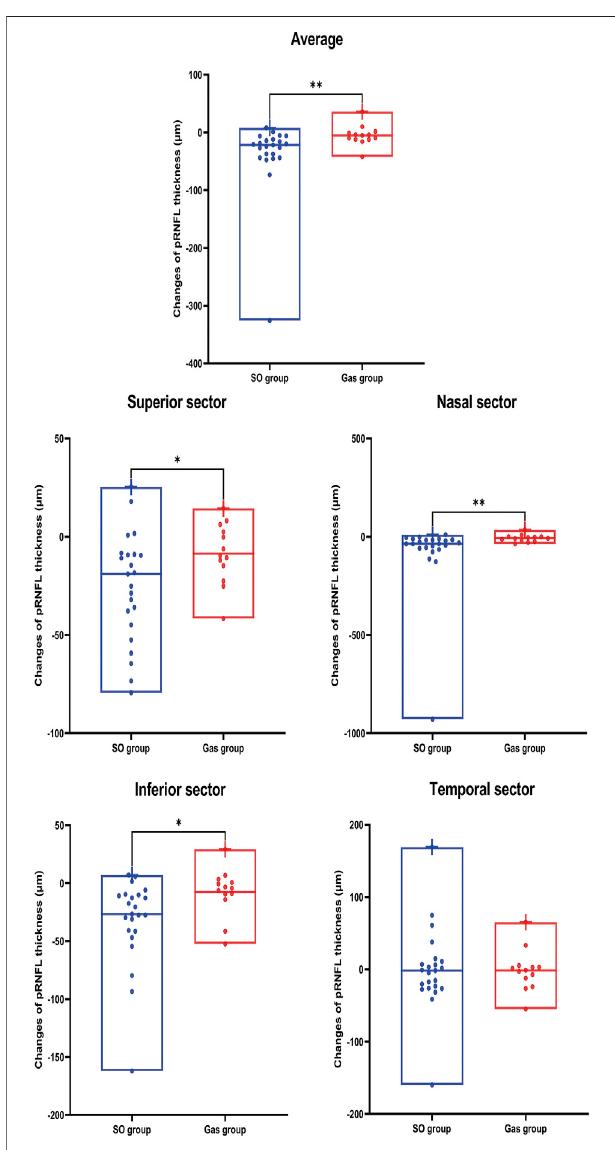
FIGURE2| Changes inpRNFLthicknesson averageand in each sector werecomparedbetweenthetwogroups.SO,siliconeoil. p value:*, < 0.05;**, < 0.01; ***, < 0.001; ****, < 0.0001.